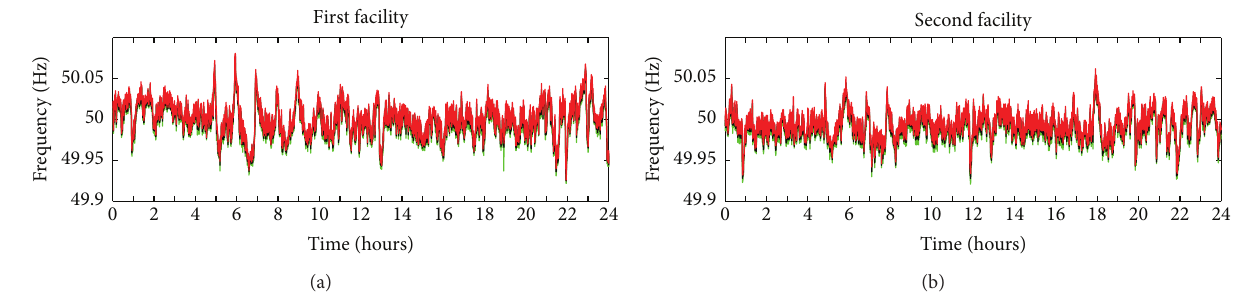
Figure 8: Frequency evolution in both facilities. The green line represents the minimum voltages, the black line represents the medium voltages, and the red line represents the maximum voltages.